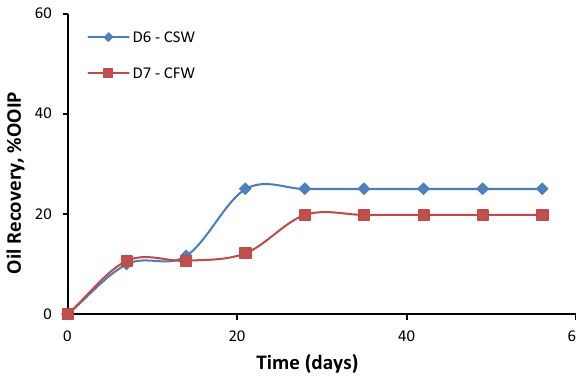
Fig. 6 Oil recovery from limestone cores with CSW and CFW at 64 (cid:3) C Fig. 7 Oil recovery of dolomite cores with CSW and CFW at 64